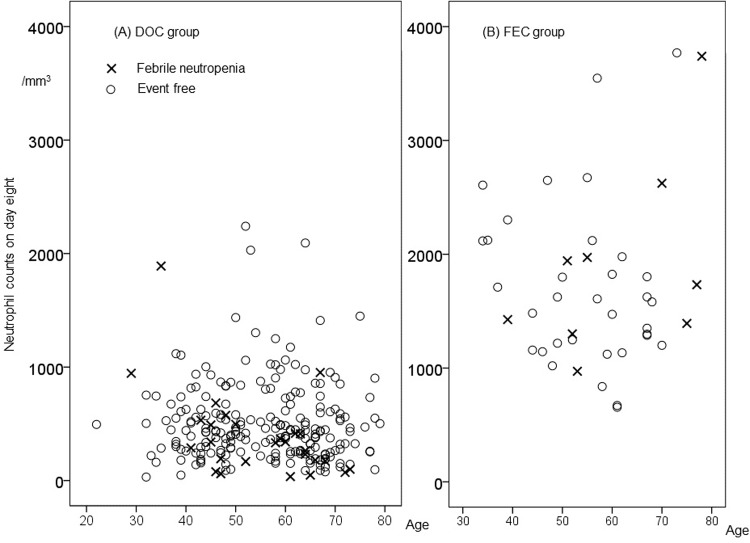
Febrile neutropenia and neutrophil counts on day 8 versus age.(A) in DOC group and (B) in FEC group, a scatter plot of age versus neutrophil count on day 8 is shown, patients experienced FN during a planned cycle were shown in punctuation mark (x) and who did not open circle (o).